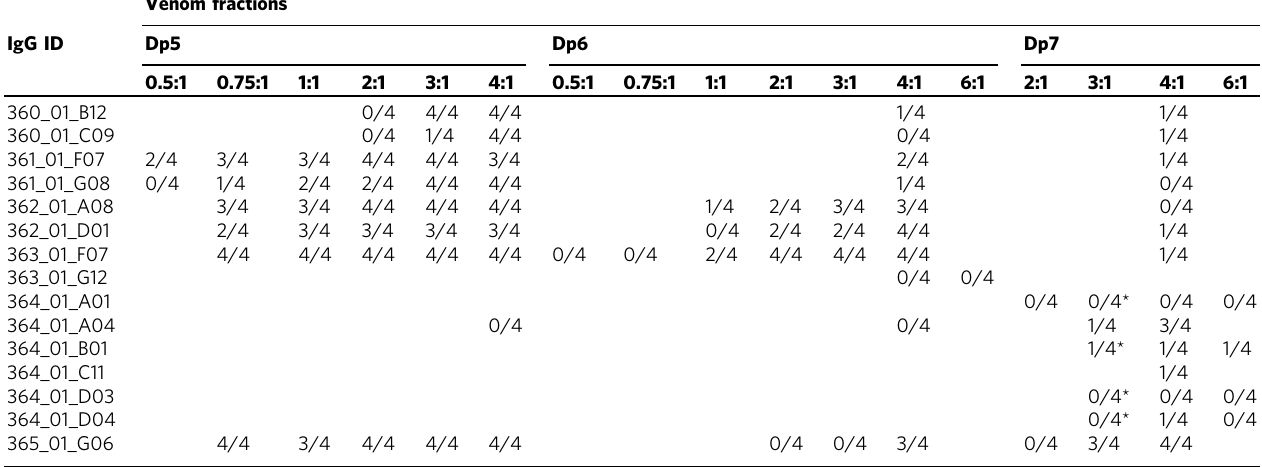
Table 2 In vivo neutralization results for monoclonal IgG antibodies raised against Dp5, Dp6, and Dp7 Venom fractions